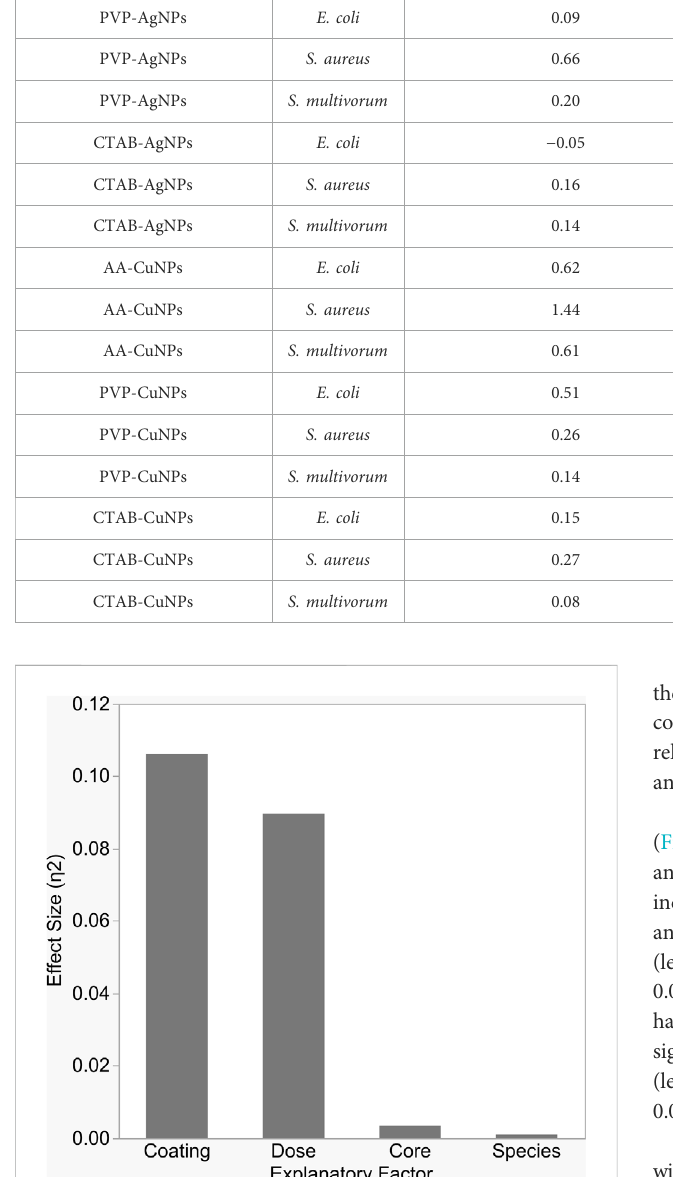
FIGURE 3 Each variable in the study signi fi cantly impacted bacterial growth inhibition, but the size of impact differed between variables. As shown here, surface coating and dose explained the largest proportions of variation in inhibition, as measured by partial The major contributors to bacterial inhibition in this study are highly dependent upon the surface coating and dose. Dose produced a linear effect. The effect of surface coating, however, is mediated by